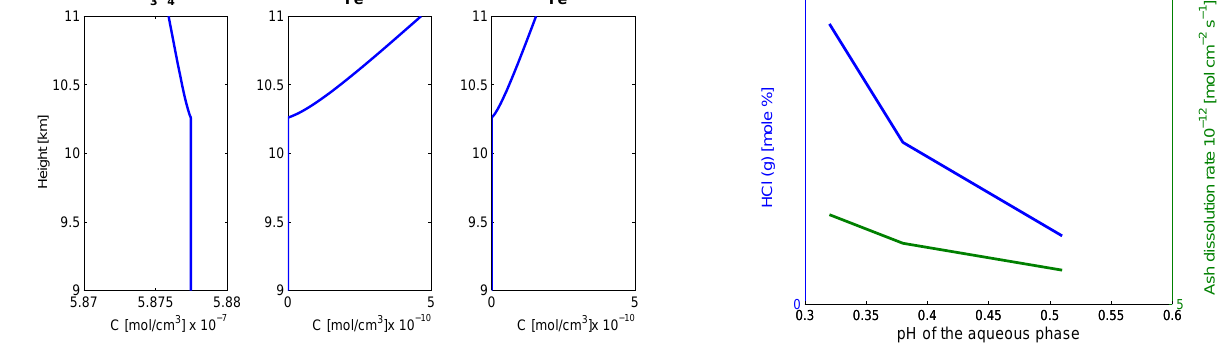
Figure 6. Vertical profile of magnetite (Fe 3 O 4 ), iron II and iron III concentrations. Because of relatively slow dissolution rates in the reference scenario, changes in magnetite concentration are small. Note that only the height > 9km is plotted here.